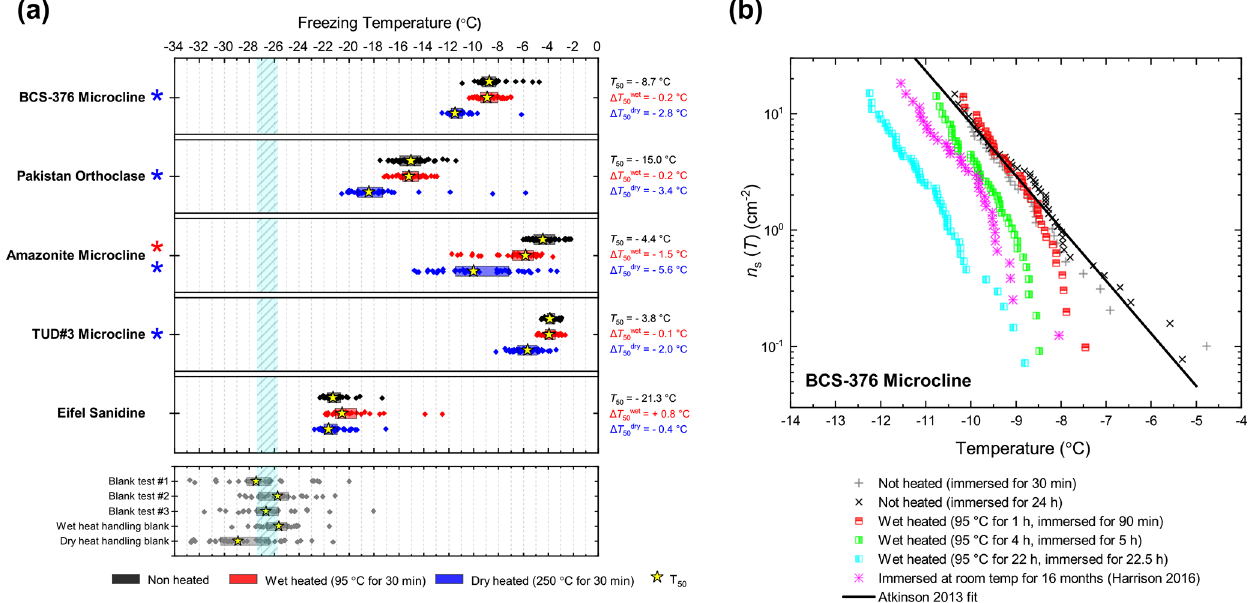
Figure 2. (a) Boxplot showing freezing temperatures before (black) and after heat treatments (red for wet heat, blue for dry heat) for all K- feldspar samples. Asterisks ( ∗ ) next to the sample name indicate significant deactivation by wet (red) or dry (blue) heating; this is defined as a reduction in T 50 of more than 1.2 ◦ C. Boxes represent the 25%–75% percentile, points represent individual droplet freezing temperature, and stars represent the temperature at which half of the droplet population had frozen (i.e. T 50 ). Clean water blank freezing temperatures are illustrated by the blue band, which denotes the range of T 50 temperatures obtained from four blank droplet freezing runs. Blank runs and handling blank runs are shown below the main boxplot. (b) Active site density per surface area ( n s (T ) ) spectrum for BCS-376 microcline after extended wet heat treatment compared to room-temperature ageing experiments from Harrison et al. (2016). The parameterisation for the ice-nucleating activity of K-feldspar from Atkinson et al. (2013) is also